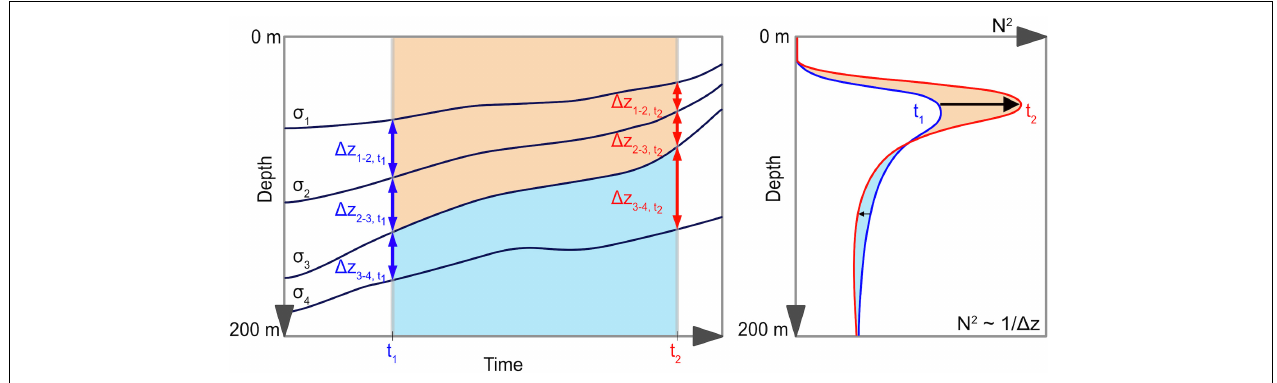
FIGURE 3 | Schematic of a pure heaving process as a result of intensified wind curl-driven upwelling. Dark blue lines indicate different isopycnals ( σ 1 , σ 2 , σ 3 , and σ 4 ) whose depth is changing over time. Due to the upwelling of the isopycnals, the height difference (cid:49) z between two isopycnals changes over time (compare time steps t 1 and t 2 ). If the (cid:49) z decreases as for the upper two pairs of isopycnals ( (cid:49) z 1 − 2 , (cid:49) z 2 − 3 ) from time step t 1 (blue double arrows) to t 2 (red double arrows), the stratification in terms of the Brunt–Väisälä frequency N 2 increases as indicated in the right panel by the typical stratification profile. Here the blue line of the N 2 profile corresponds to the time step t 1 as in the left panel . The red profile indicates the profile for t 2 . In both panels the depth range where stratification increases, is shaded light orange. In contrast, if the height difference becomes larger over time as for the lower pair of isopycnals ( (cid:49) z 3 − 4 ), stratification will be reduced. The depth range where stratification decreases is marked light blue in both